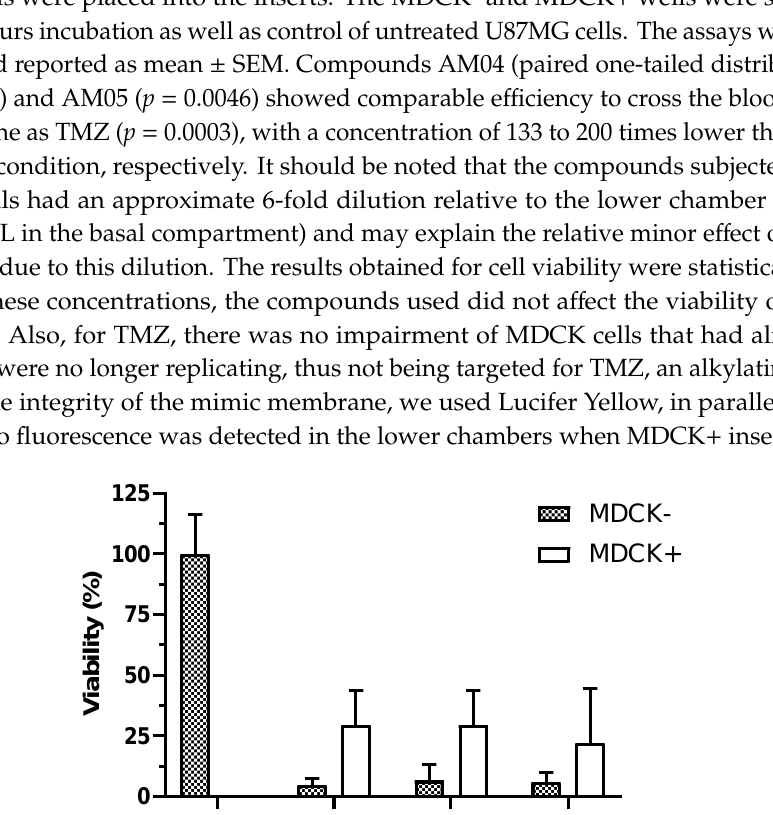
Figure 4. Percentage of wound closure of U87MG ( A ) and T98G ( B ) cells after the different treatments were analyzed by the wound healing assay compared to untreated control (DMSO). AM04 (0.55 and 1.10 µM for T98G and U87MG, respectively); AM05 (0.83 and 1.66 µM for T98G and U87MG, respectively) and 2.05 µM THP, 0.5 mM TMZ and 8 µg/mL TUN for both cell lines. Data were represented as mean ± SEM, n = 4. For comparative analysis of groups of data one-way ANOVA was used, followed by Dunnett’s multiple comparisons test, performed using GraphPad Prism version 8.0.2. for Windows, GraphPad Software, San Diego, California USA, www.graphpad.com. The p values are presented in the figure. *: significant, p values range between 0.01 to 0.05.